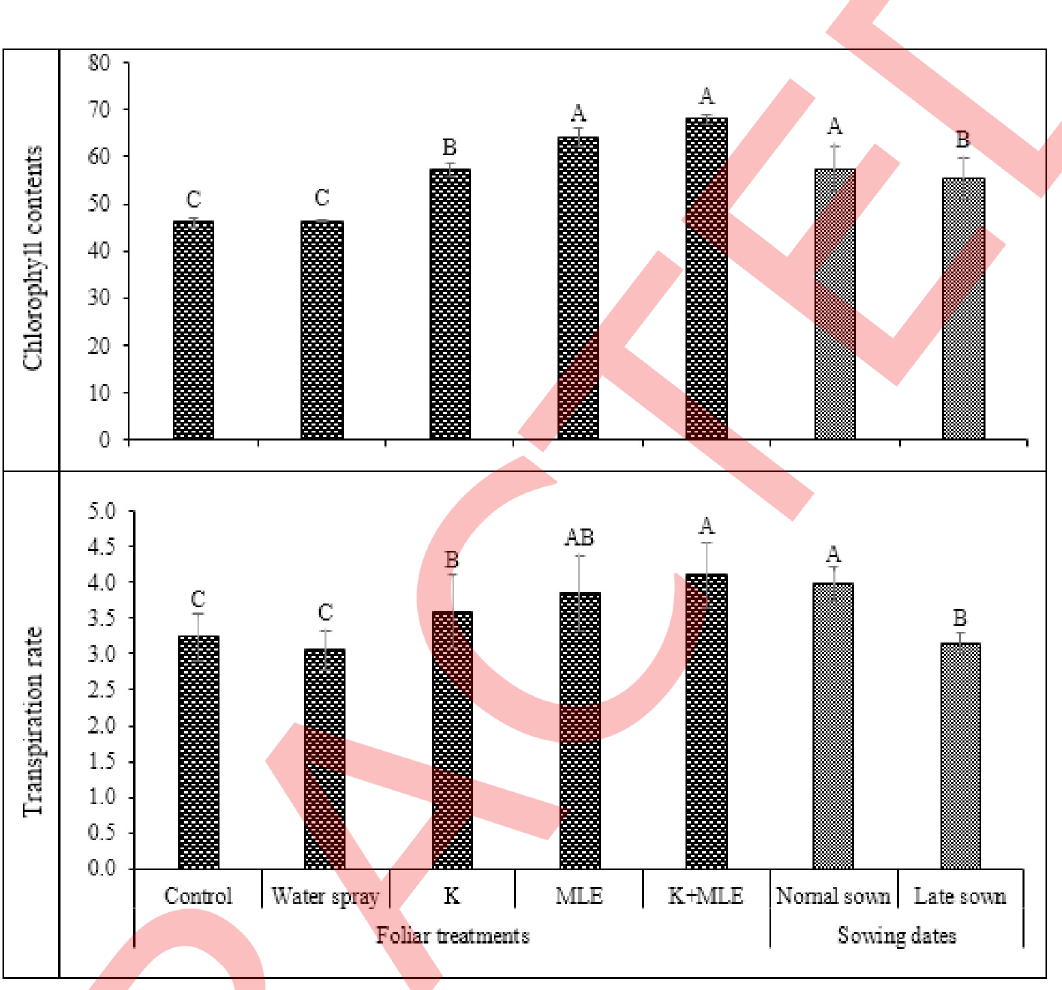
Fig 2. Impact of foliar applied K and MLE on chlorophyll contents and transpiration rate of early and late sown kabuli